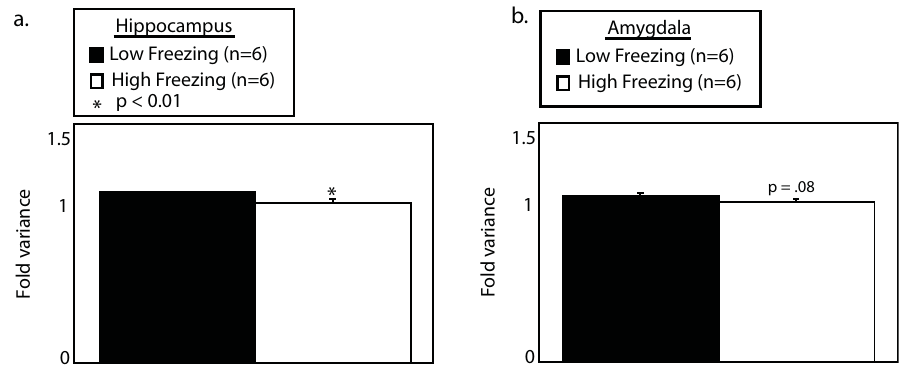
Figure 3. Variance of log-transformed gene expression levels in the hippocampus but not the amygdala is associated with contextual fear and present in genetically heterogeneous mice. Gene expression data was downloaded from the Gene Expression Omnibus public repository (GSE4034 & GSE4035 (supplemental figure S4)). Mice for these experiments were selected over multiple generations after an inter- strain cross of a high anxiety (DBA or A/J) and low anxiety (C57/B6) strain of mice. We found that variance of log-transformed gene expression levels in the hippocampus but not amygdala was significantly increased in low freezing mice. In this study low freezing mice were found to have increased activity in the open-field similar to high activity and handled mice [14].